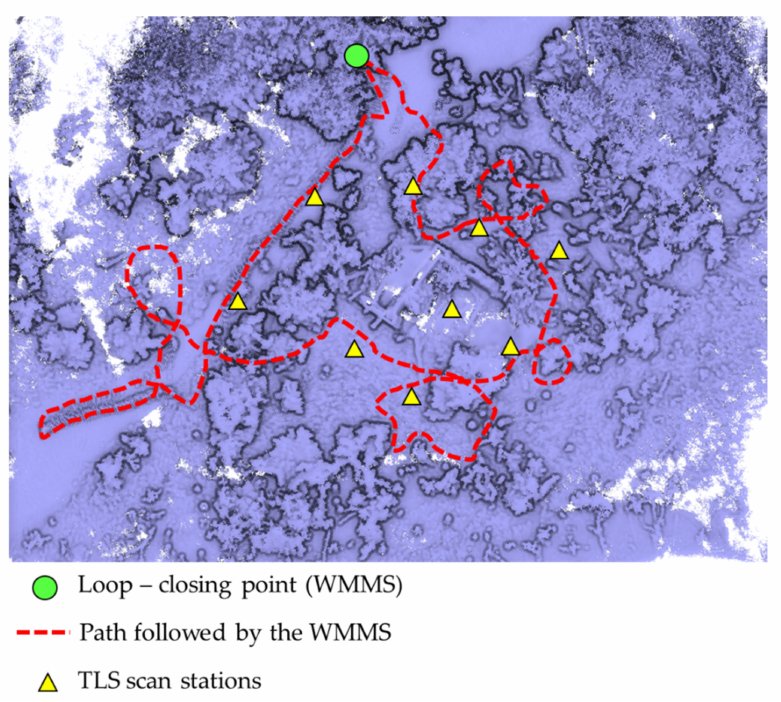
Figure 10. TLS scan stations and path followed during the data acquisition with the